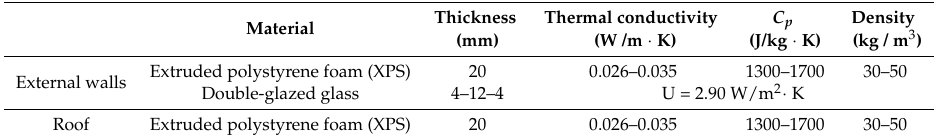
Table 8. Spanish Basic Energy Saving Requirements (DB-HE) regulation: additional thermal insulation— Scenario 3.